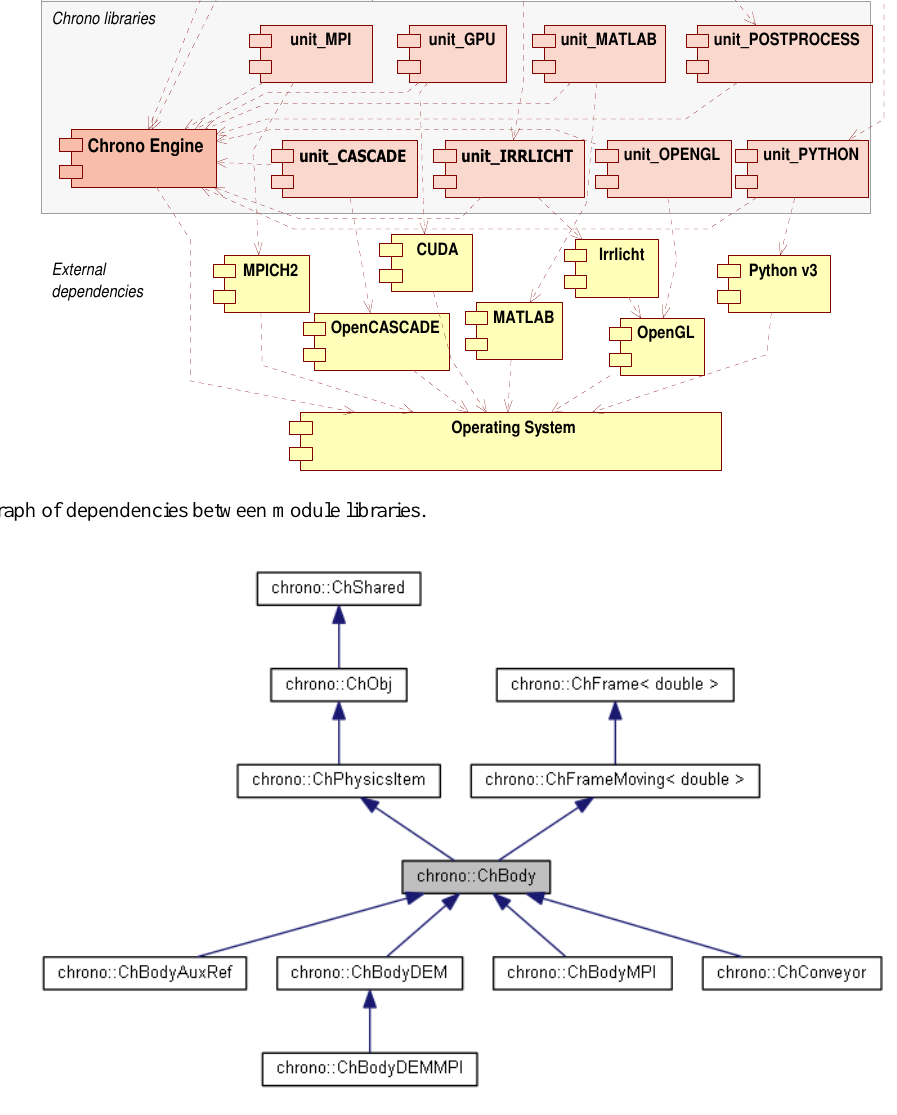
Figure 2. Class ineritance diagram for objects of ChBody